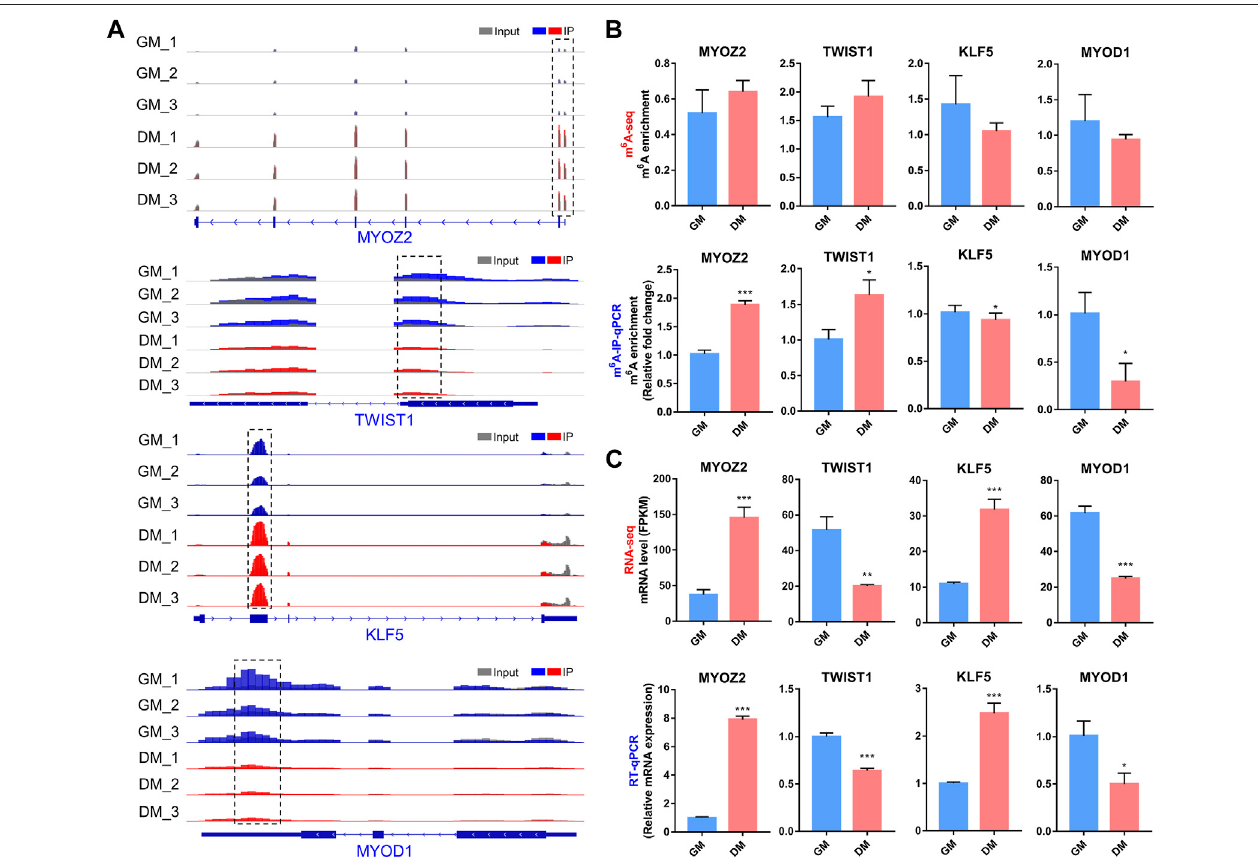
FIGURE 7 | Changes in m 6 A and mRNA levels in transcripts of 4 myogenesis-related genes during bovine myoblast differentiation. (A) IGV tracks displaying the distribution of m 6 A peaks in MYOZ2, TWIST1, KLF5 and MYOD1 transcripts in all six groups. (B) Validations of the m 6 A enrichment by m 6 A-IP-qPCR. (C) mRNA expression levels of MYOZ2 , TWIST1 , KLF5 and MYOD1 were revealed and veri fi ed by RNA-seq and RT-qPCR, respectively. Data were presented as the means ± SD. * p < 0.05, *** p < 0.001, ** p < 0.01; using Student ’ s t test.